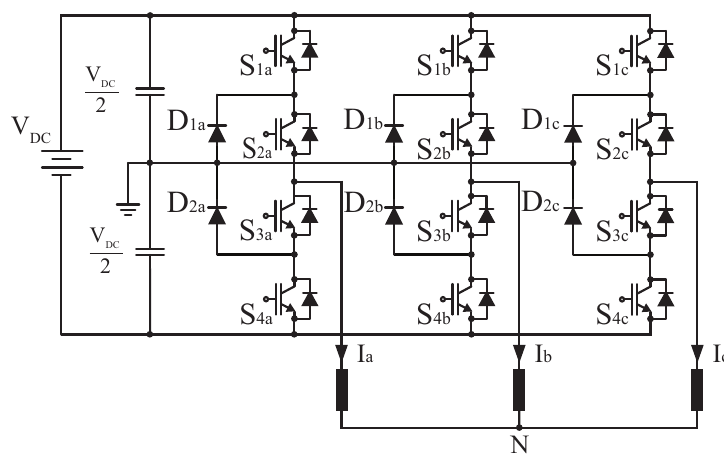
Figure 2. Three-level Neutral Point Clamped (NPC) inverter topology. Table 1. Switching states for a three-level NPC